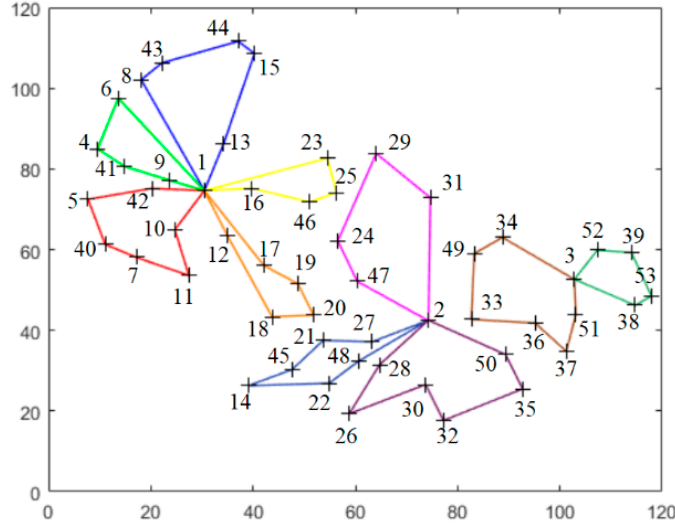
Figure 10. The dynamic path of the agricultural machinery cooperatives in the second stage.